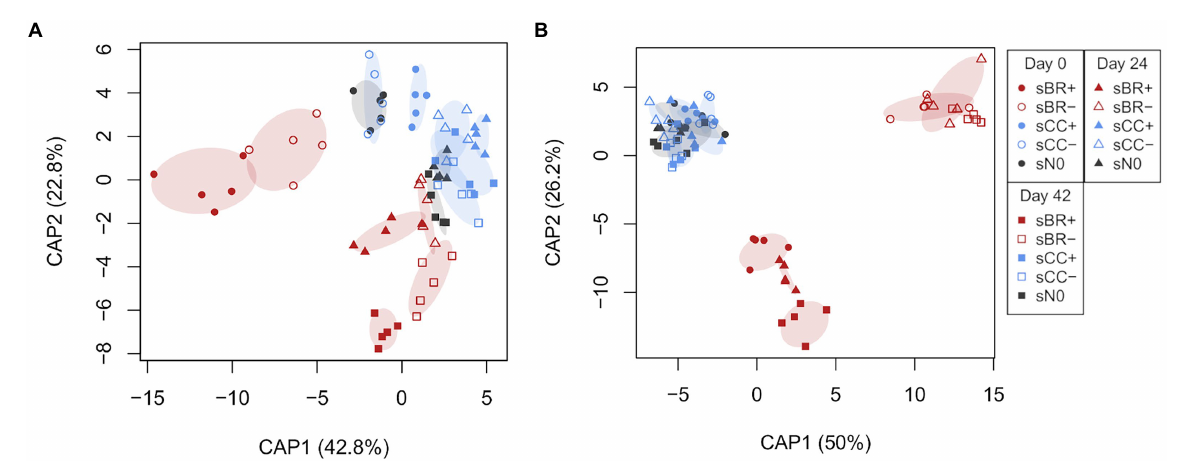
FIGURE 3 Constrained analysis of principal coordinates (CAP) ordinations elucidating a priori differences in bacterial/archaeal (A) and fungal (B) community structure upon fertilizer amendment at days 0, 24, 42 of the experiment. Percent between group variation represented by each canonical axis are provided in parentheses next to the axis headers. CAP reclassification success rates for bacteria/archaea at day 0: sBR+, 100%; sBR-, 100%; sCC+, 100%; sCC-, 60%; sN0, 80%; day 24: sBR+, 80%; sBR-, 80%; sCC+, 100%; sCC-, 40%; sN0, 80%; day 42: sBR+, 100%; sBR-, 100%; sCC+, 40%; sCC-, 60%; sN0, 80%. CAP reclassification success rates for fungi at day 0: sBR+, 80%; sBR-, 100%; sCC+, 0%; sCC-, 20%; sN0, 60%; day 24: sBR+, 100%; sBR-, 100%; sCC+, 0%; sCC-, 60%; sN0, 80%; day 42: sBR+, 100%; sBR-, 100%; sCC+, 40%; sCC-, 40%; sN0, 0%. sBR+, soil fertilized with BSFL residue; sBR-, soil fertilized with sterile BSFL residue; sCC+, soil fertilized with conventional compost; sCC-, soil fertilized with sterile conventional compost; sN0, no-fertilizer